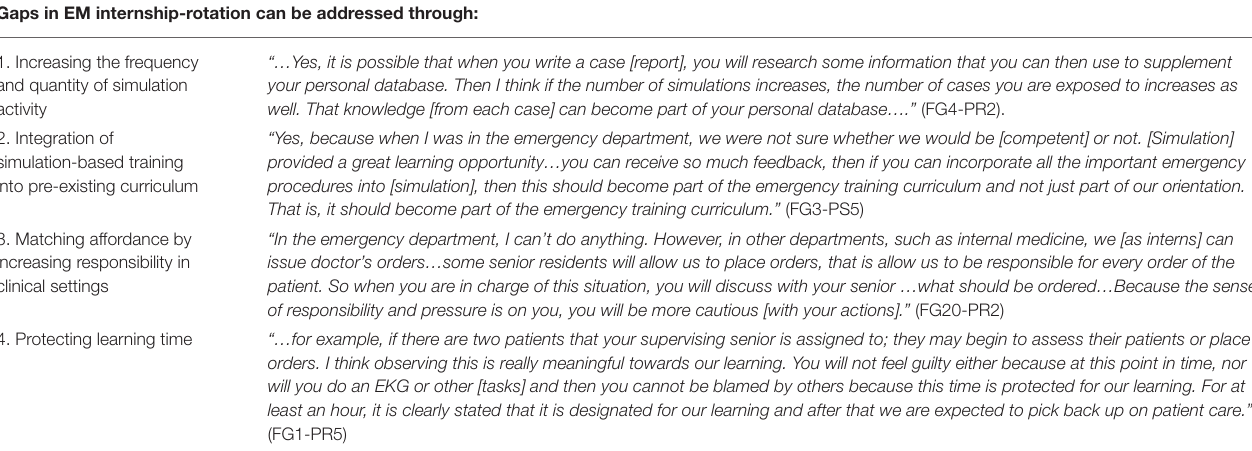
TABLE 5 | Representative quotes of theme 4—Suggestions for EM block- internship curriculum reforms. Gaps in EM internship-rotation can be addressed